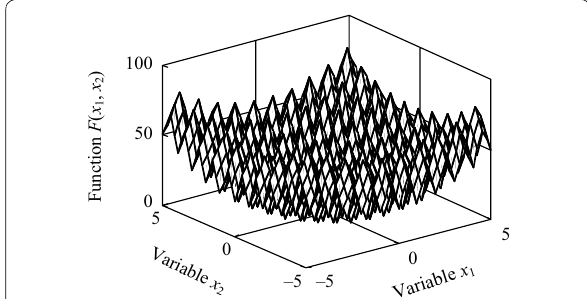
Figure 1 Rastrigin benchmark